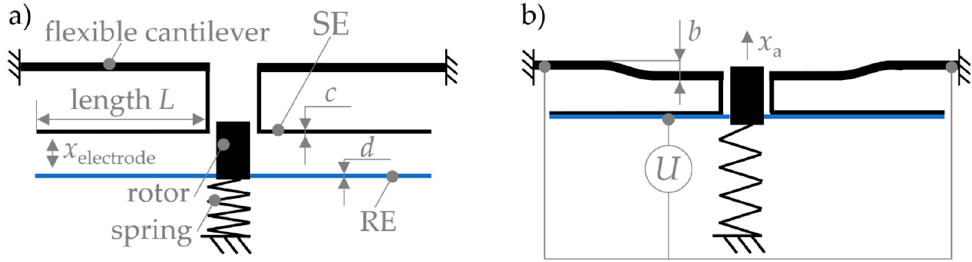
Figure 1. ( a ) Setup of the bending plate actuator, ( b ) completely pulled-in bending plate actuator, (drawings not to scale).